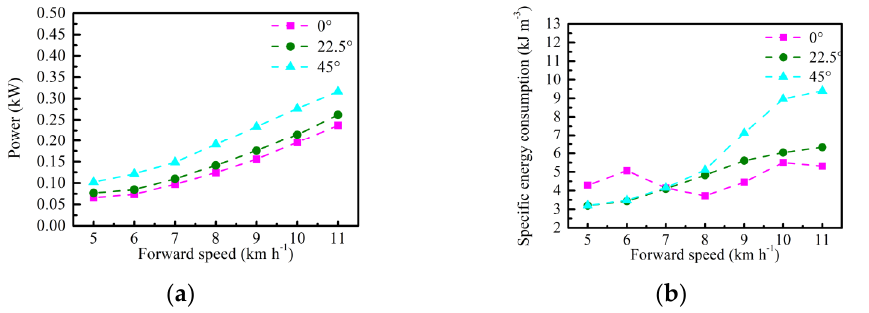
Figure 6. Effect of operating speed on power and specific energy consumption; ( a ) effect of operating speed on power; ( b ) effect of operating speed on specific energy consumption.